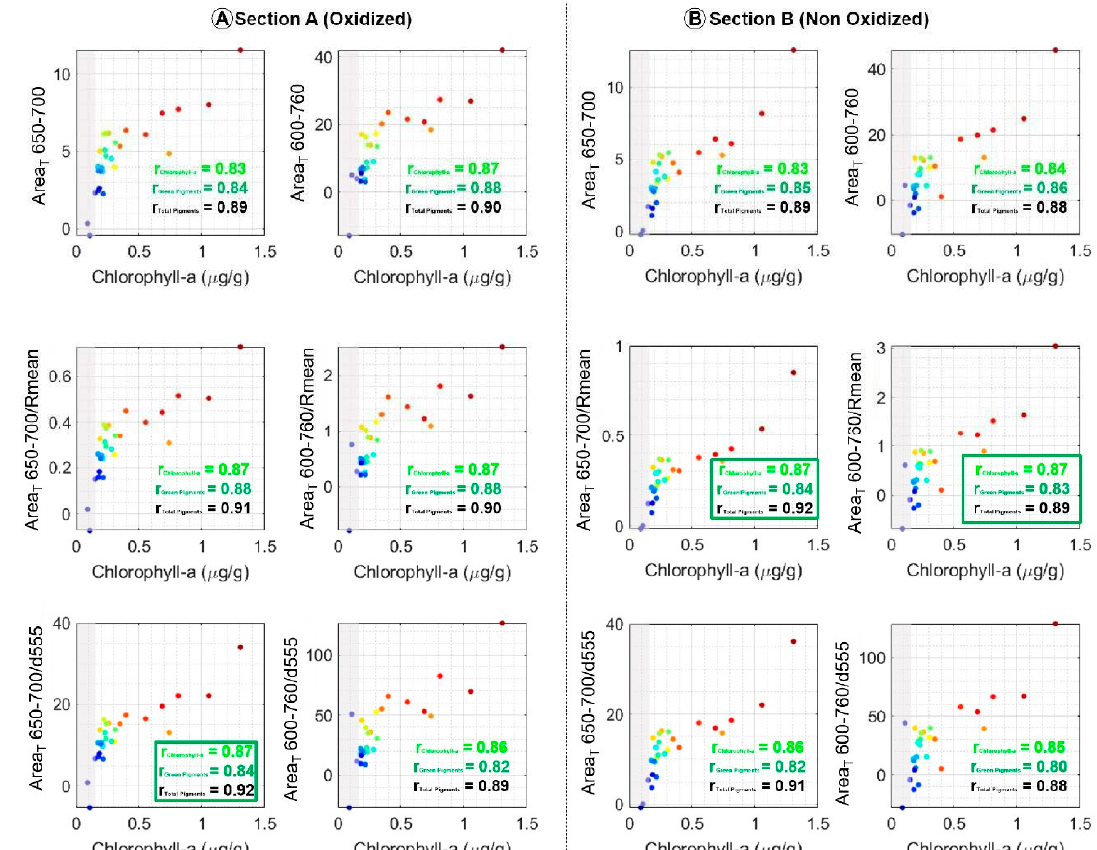
Figure 5. Scatter plots of new indices aimed at removing the effect of the sediment composition for sections ( A ) (oxidized) and ( B ) (unoxidized). Rmean normalization improves correlations with chlorophyll- a concentration measured for Area T 650–700 and Area T 600–760 on section ( B ), but only for Area T 650–700 on section ( A ) due to the reduced size of the absorption band of chlorophyll in this section. Normalization by d555 (iron oxide index) improves the correlation only for section A due to the absence of iron oxide in section B. N.S. = Not Significant with p -value > 0.0001 (n = 28). The red dots indicate the top of the core and the blue color is for bottom.